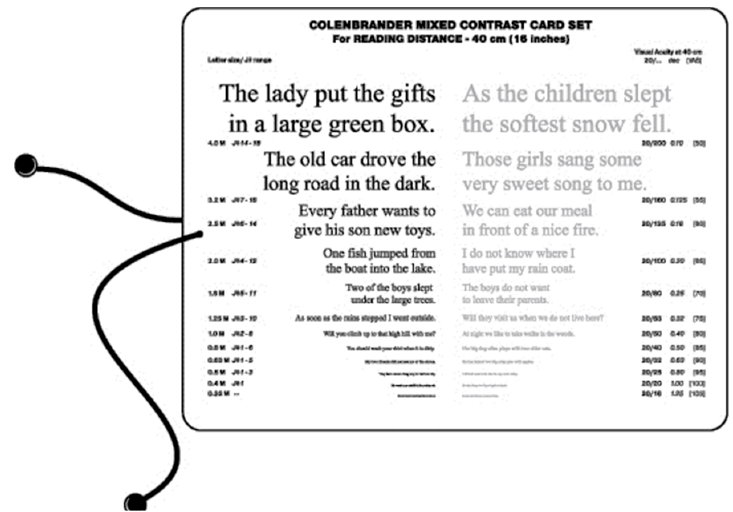
Figure 19. Mixed Contrast reading card.